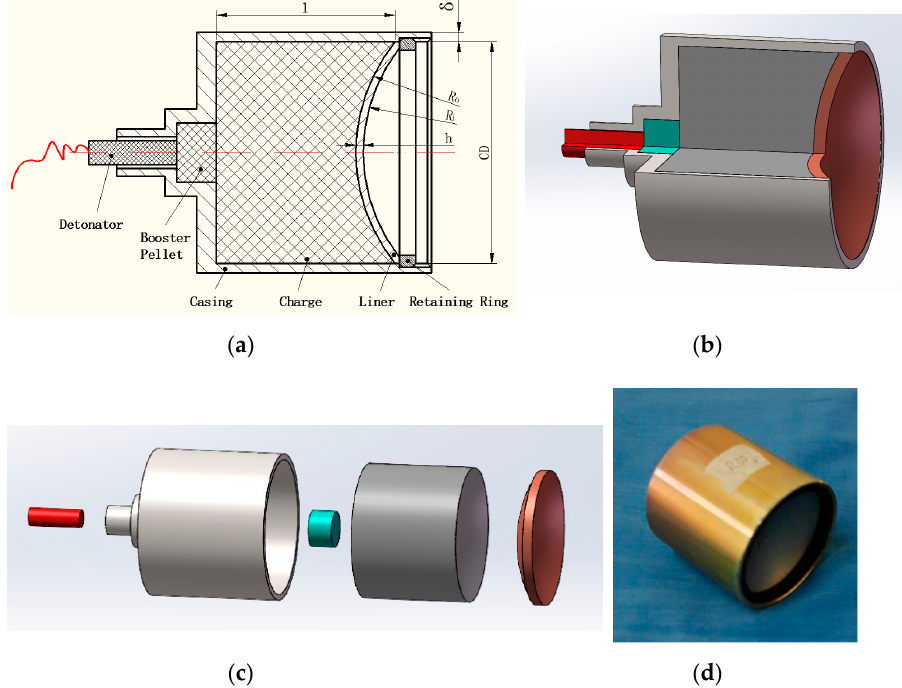
Figure 1. EFP charge structure. ( a ) 2D geometric sketch. ( b ) 3D geometric sketch. ( c ) Components structure. ( d ) Assembly structure.